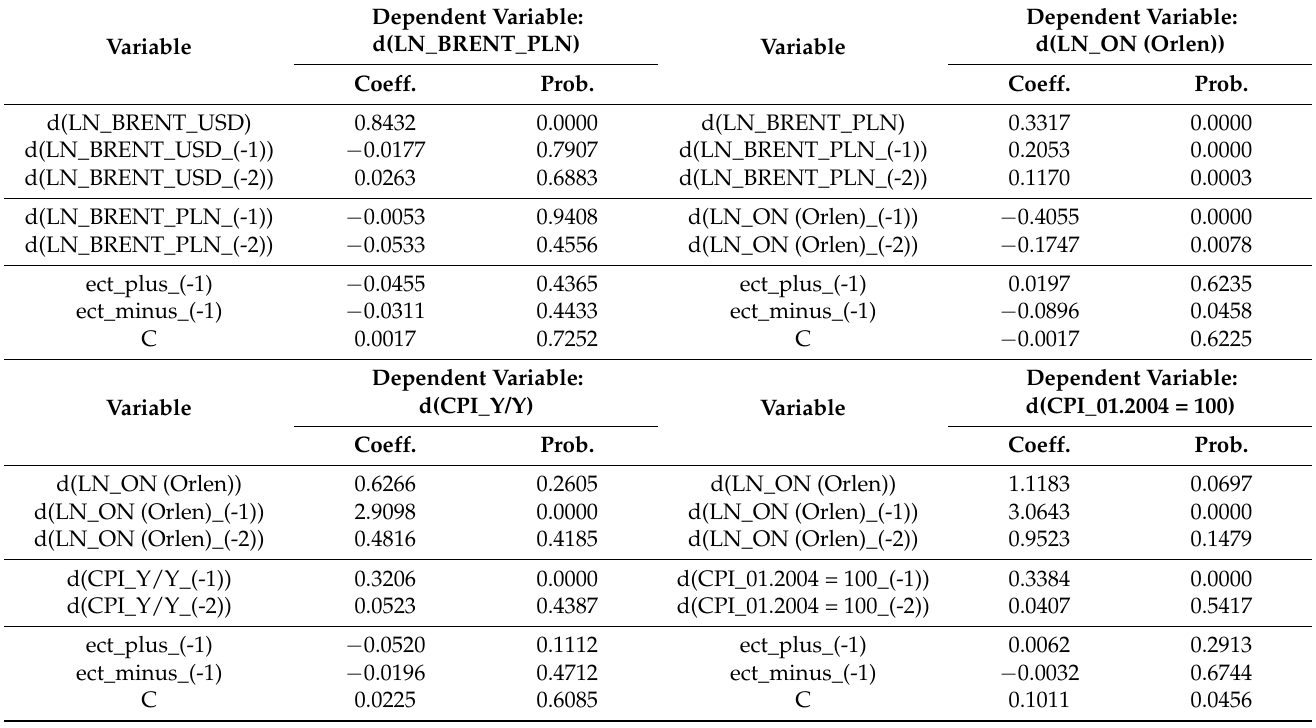
Table 7. ECT models with